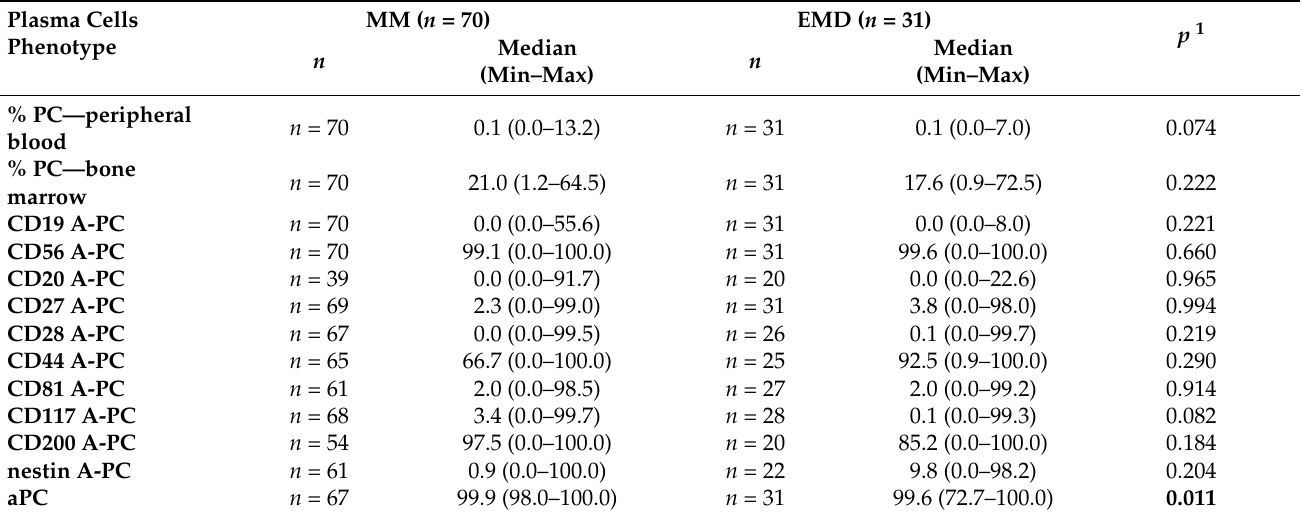
Table 1. Flow cytometry analysis at diagnosis of multiple myeloma (MM) and extramedullary myeloma (EMD) patients. Median of relative expression on abnormal plasma cells (A-PCs) is shown